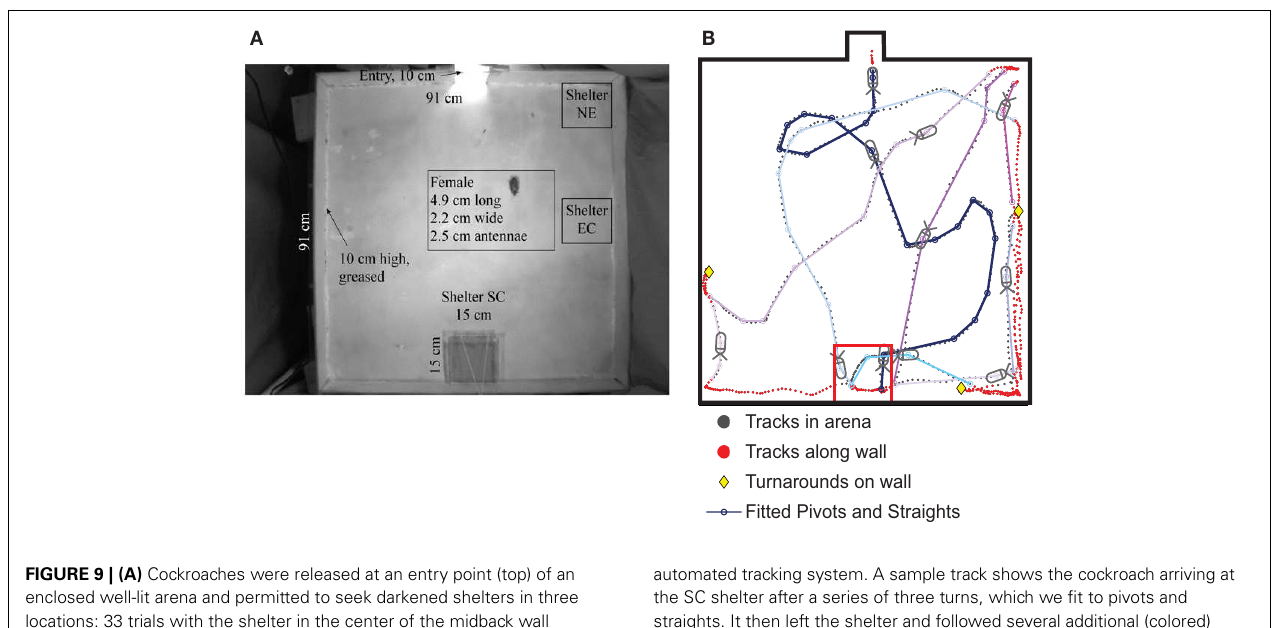
states: “pivot” or “straight” in the center of the arena and “follow wall,” “turnaround,” or “depart wall” when along the wall. Each state had an associated behavior: walk in a line for “straight,” turn in place for“pivot,”and maintain constant wall distance for“follow wall,”etc.Transitionsfromonestatetoanotheroccurredstochasti- cally based on state transition rates,which were extracted from the cockroach data. For example, to quantify the connection between the“follow wall”state and the“depart wall”state, we measured the wall departure rate of two departs per meter by counting the num- ber of times animals left the wall and dividing by their total path length along the wall. Since we measured the speed of the animal along the wall to be ∼ 0.09 m/s, over a given time period of say,